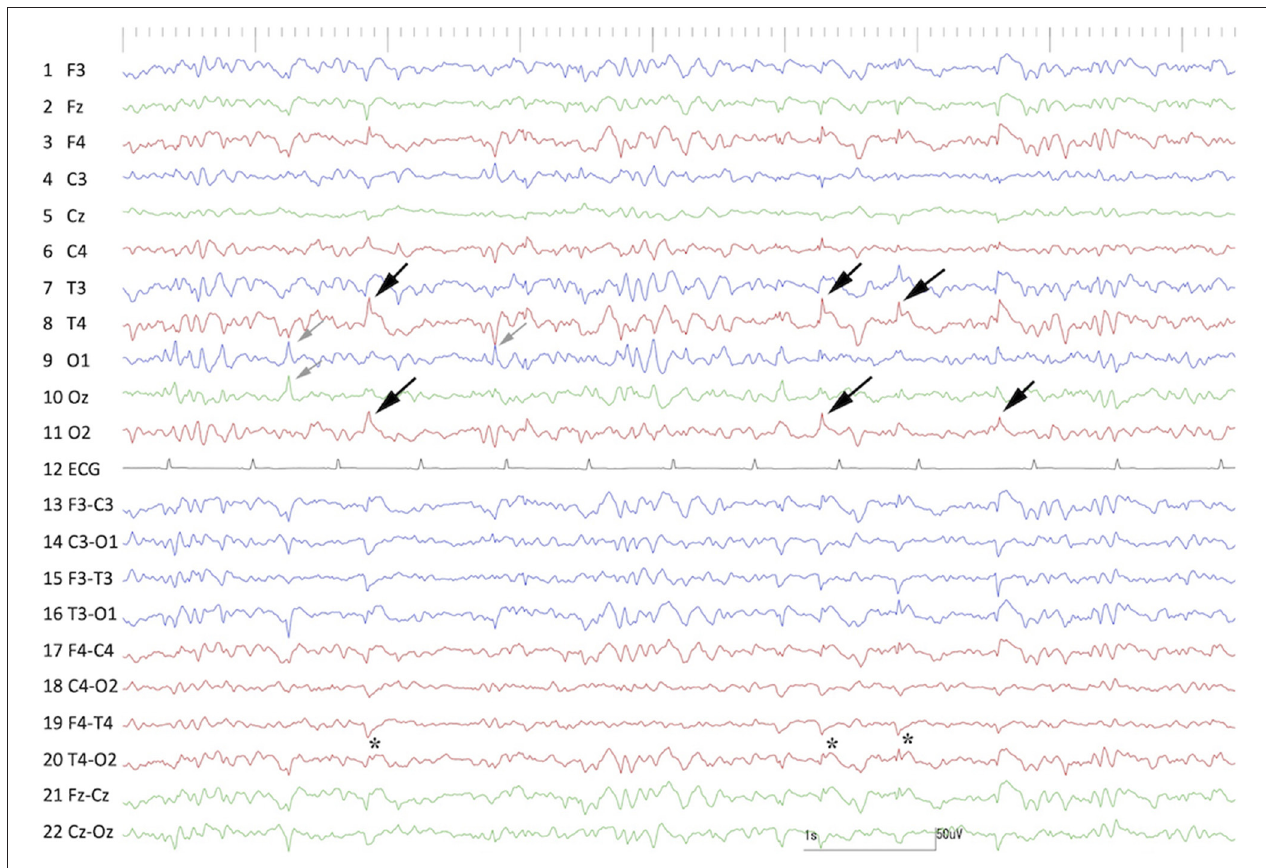
FIGURE 1 | Preoperative interictal scalp EEG under sedation with medetomidine. Remarkable spikes were observed frequently at T4 and O2 (black arrows) with phase reversal ( ⋆ ) at T4. Sporadic spikes were observed at O1 and Oz (gray arrows). Channels 1–11 were monopolar, and channels 13–22 were bipolar montages. Channel 12 was